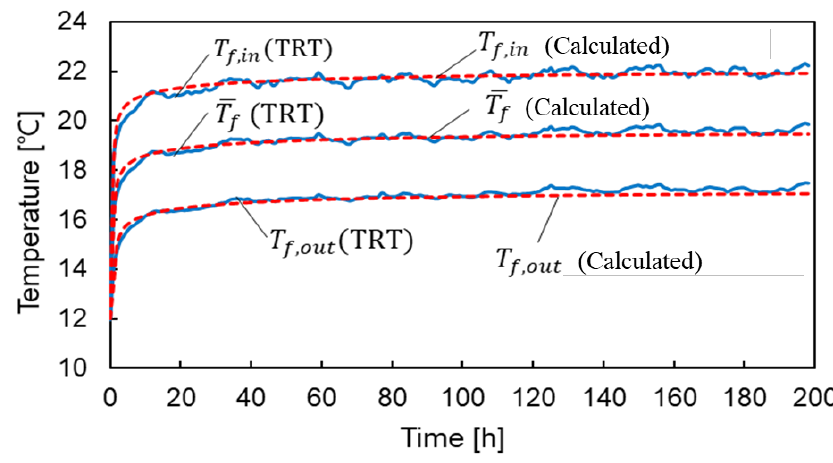
Figure 11. Comparison between the calculated results and the TRT data.